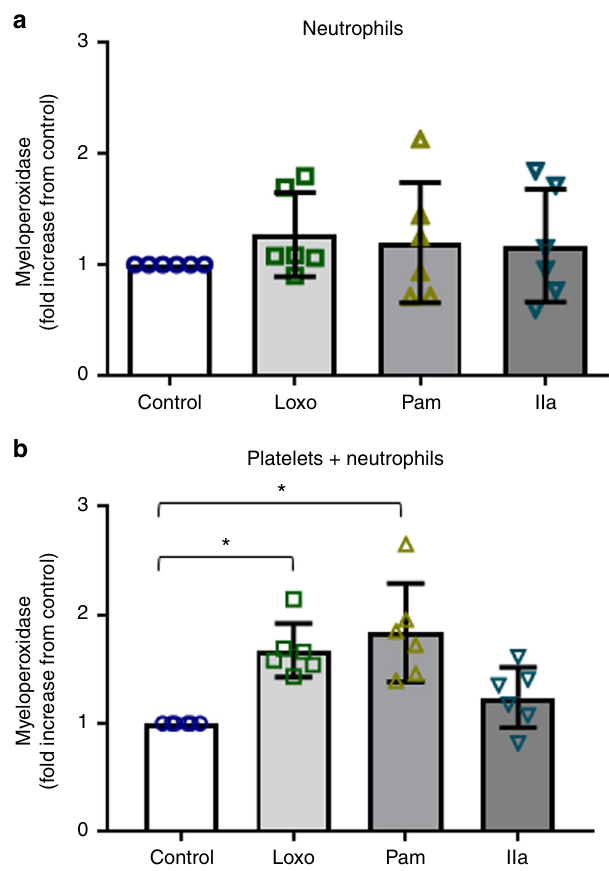
Fig. 8 Platelet-TLR7mediates release of MPO from neutrophils. Isolated human platelets and neutrophils were incubated together or by themselves for 30 min, at 37 °C and constant rotation, in the presence of TLR agonists [TLR7 (Loxo) — 1 mM; TLR2 (Pam) — 10 μ g/mL] or thrombin (IIa) — 0.05 U/ mL. Myeloperoxidase (MPO) release from neutrophils was measured in the a absence ( p = 0.7206, F = 0.4493, df = 3) and b presence of platelets by ELISA ( p = 0.0002, F = 10.4, df = 3). The graphs represent the average fold change for each individual of n = 6 (3F; 3M) ± SD. Source data are provided as a Source Data fi le. Signi fi cance was measured by ANOVA followed by Bonferroni follow-up test; in all cases star symbol (*) indicates p <